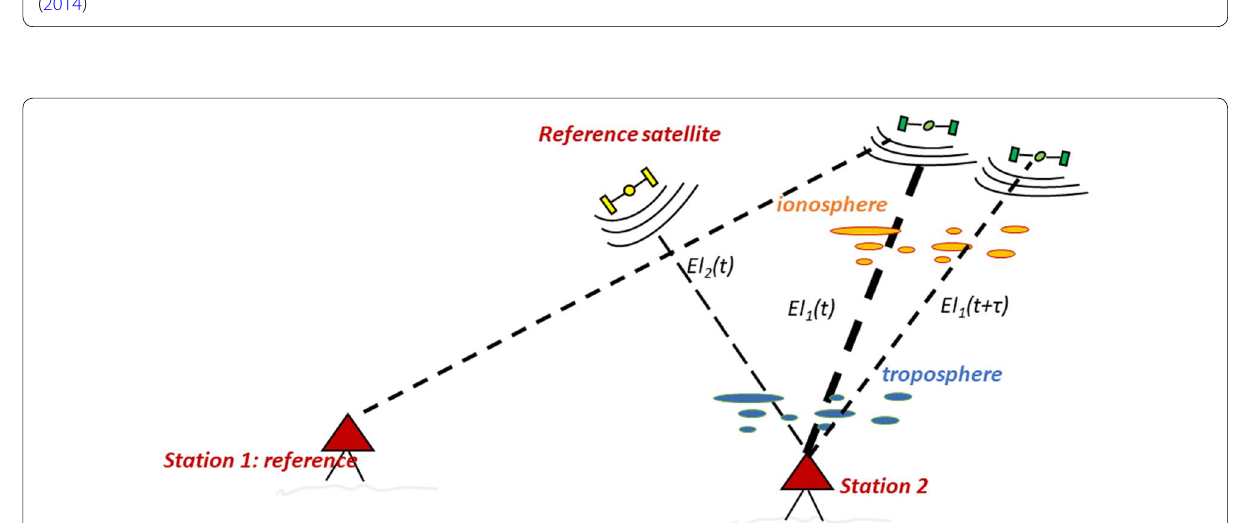
Fig. 5 Impact of the atmosphere on GNSS signals for a relative positioning